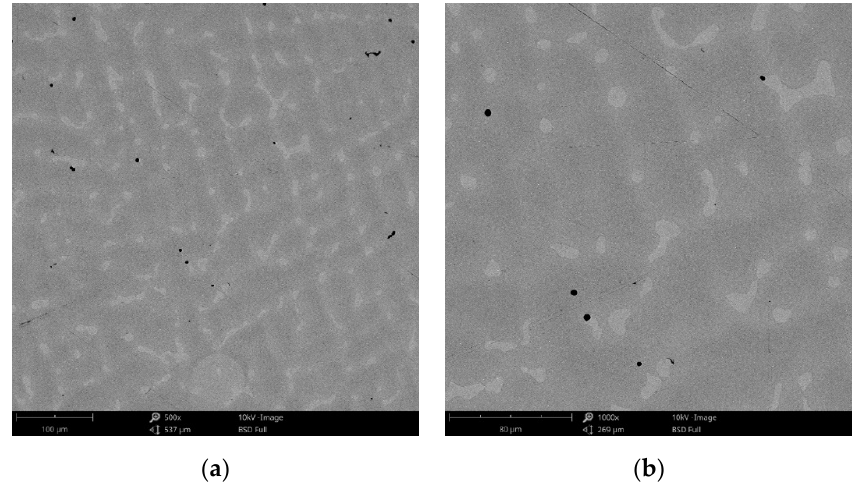
Figure 12. SEM images of the CCc-3 sample after corrosion tests at ( a ) 500×; ( b ) 1000×.